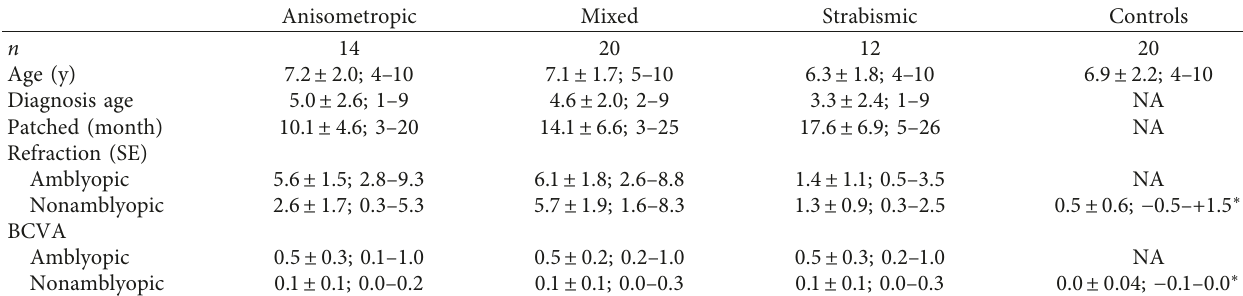
Table 1: Subject demographics and clinical characteristics (mean ± SD; range).